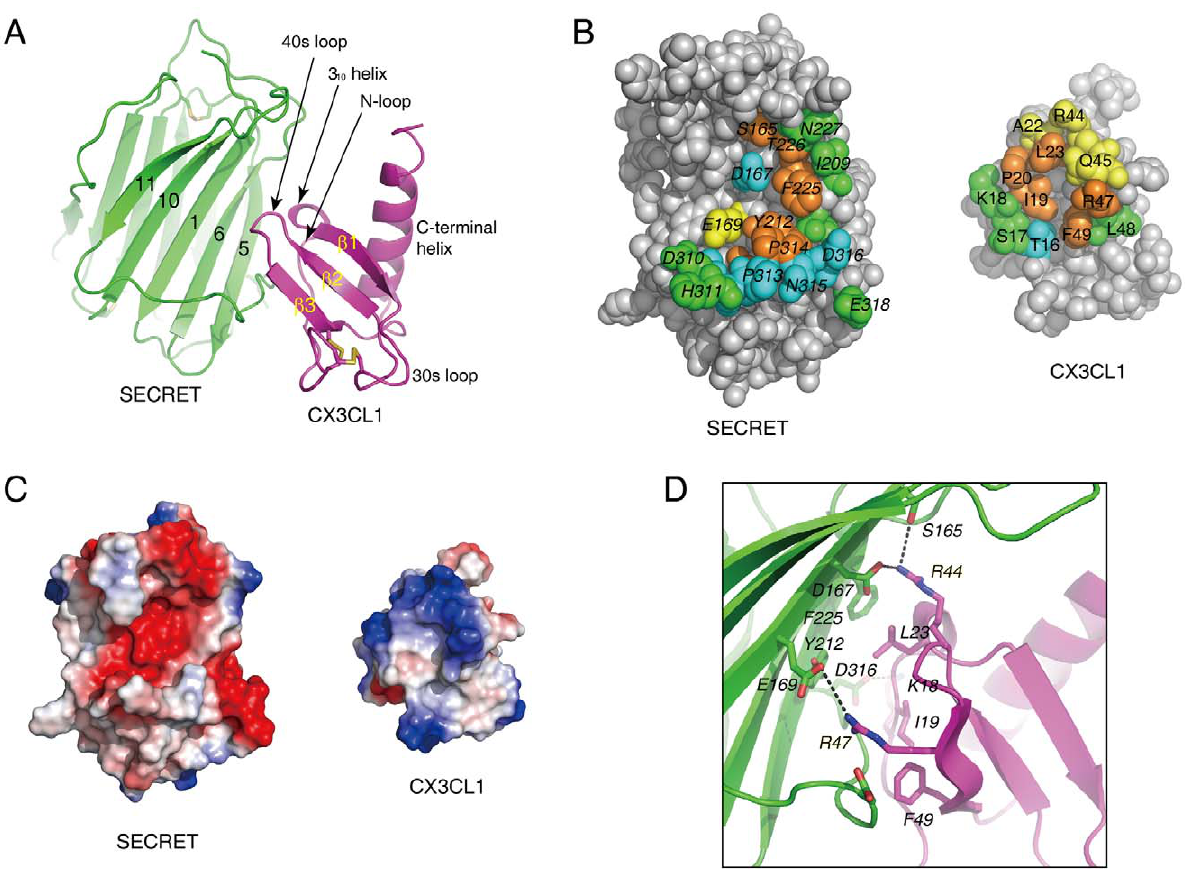
Figure 4. Crystal structure of the SECRET/CX3CL1 complex. (A) Ribbon diagram of the SECRET domain (green) in complex with CX3CL1 (purple). (B) Residues at the binding interface. Residues with solvent accessible surface decrease of above 80%, 60–80%, 40–60%, and below 40% upon complex formation are colored in brown, cyan, yellow, and green, respectively. (C) Electrostatic complementarity at the binding interface. The SECRET domain and CX3CL1 are in the same orientation as in panel B. D) Detailed view of the interactions at the binding interface. Hydrophilic interactions around basic residues K18, R44, and R47 of CX3CL1 are shown as dashed lines.